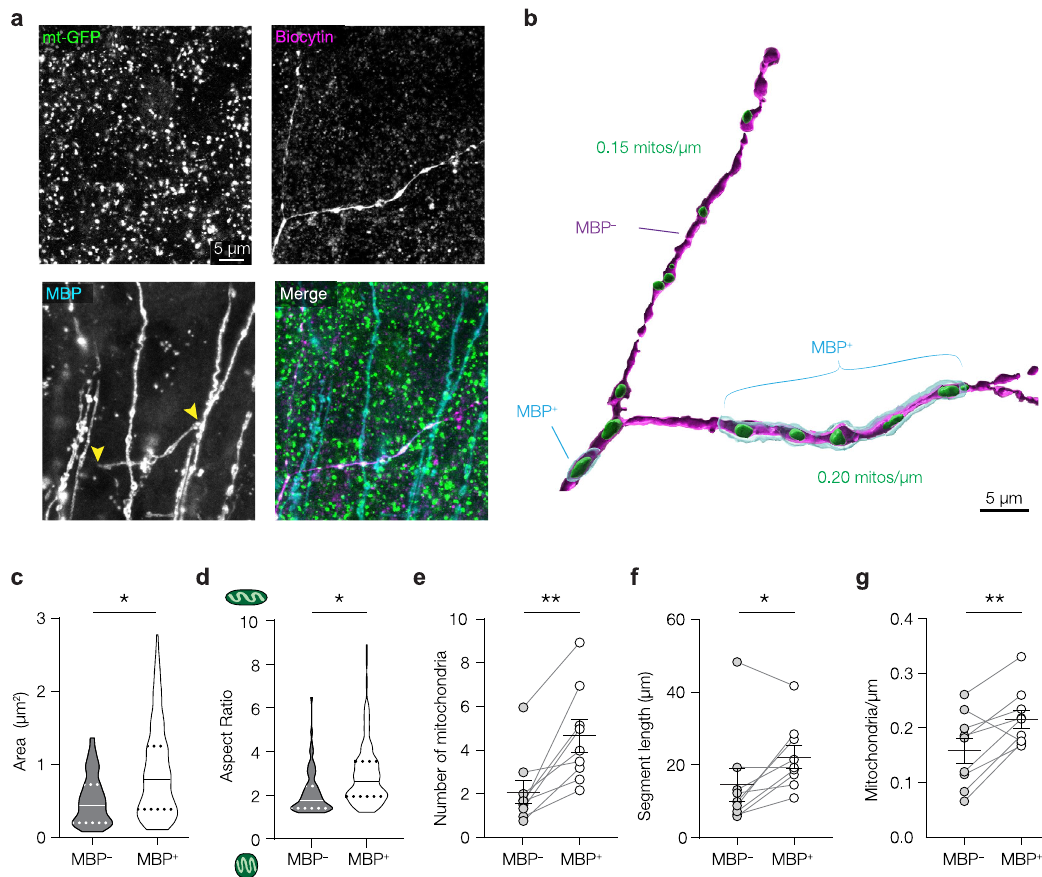
Fig. 4 | Mitochondria are clustered to myelinated segments of PV + axons. a Confocal images of a control PV + axon branch point with one myelinated (MBP + ) and one unmyelinated (MBP – ) daughter branch. Similar results were obtained in 6 mice. b 3D surface rendering of the confocal images in ( a ). c Mitochondrial area is higher at the myelin sheath (two-sided nested t-test, P =0.0121; df = 14; unmyeli- nated, n =68 mitochondria; myelinated, n =114 mitochondria, 8 axons from 6 mice). d Mitochondrialaspectratioissigni fi cantlyhigherinmyelinatedaxons(two- sided nested t-test, P =0.0388; df = 14; unmyelinated, n =68 mitochondria; myeli- nated, n =114 mitochondria, 8 axons from 6 mice). e More mitochondria in MBP +